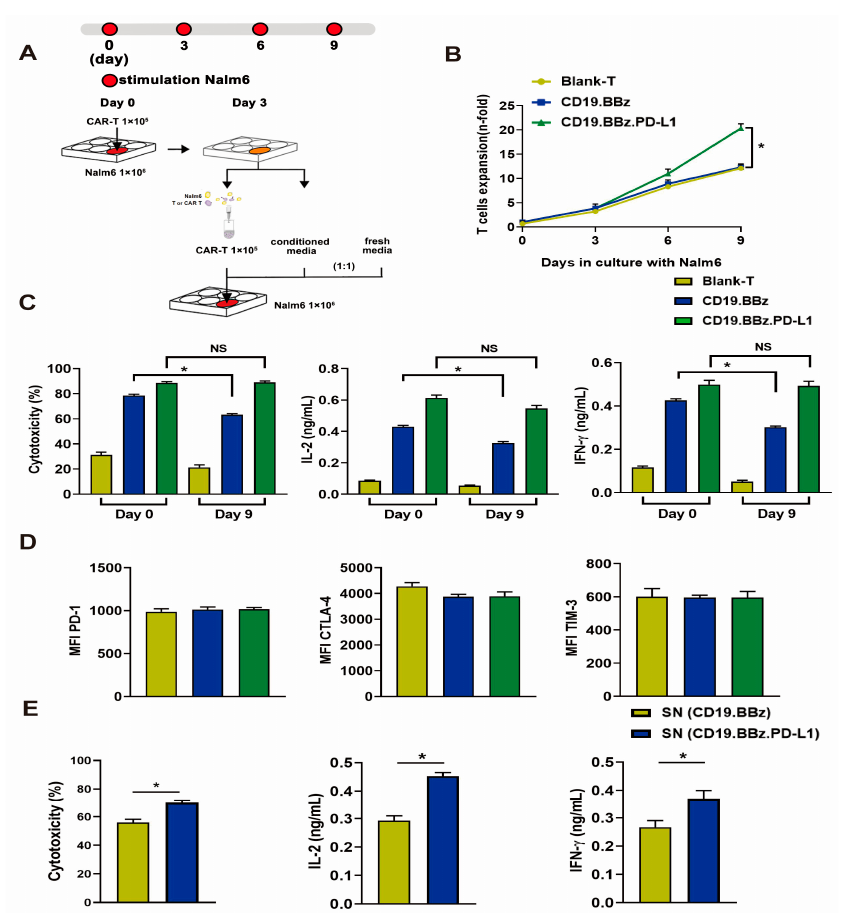
Figure 3. Effects of antigenic stimulation on cell exhaustion, cytotoxicity, cell proliferation, and cytokine secretion by blank T, CD19.BBz CAR T, and CD19.BBz.PD-L1 CAR T cells. ( A ) Scheme of the experimental procedure: 1 × 10 5 blank T cells and CAR T cells were co-cultured with 1 × 10 6 Nalm6 cells for 3 days. The culture supernatant (conditioned media) was collected and filtered. T cells were isolated by MACS CD3 microbeads, 1 × 10 5 T cells resuspended in a medium containing equal amounts of conditioned medium and fresh medium, and co-cultured with 1 × 10 6 Nalm6 cells for another 3 days. This process was repeated one more time at day 6, and the cell exhaustion experiment lasted for 9 days in total. ( B ) During the prolonged antigenic stimulation, T cells were isolated by CD3 microbeads and analyzed for cell proliferation ( n = 3). ( C ) The cytotoxicity and the cytokine secretion were measured before (day 0) and after (day 9) antigen stimulation at the E:T ratio of 1:10 ( n = 3). ( D ) The expression of T cell surface makers PD-1, CTLA-4, TIM-3 was measured by flow cytometry, and the mean fluorescence intensity (MFI) was calculated using FlowJo ( n = 3). ( E ) The effects of PD-L1 scFv secreted by CAR T cells on the cytotoxicity and cytokine secretion of CD19.BBz CAR T cells. CD19.BBz CAR T cells was co-cultured with Nalm6-Luc cells for 48 h at the E:T ratio of 10:1 ( n = 3), SN: supernatant. A total of 4 healthy donors were enrolled in our studies and we